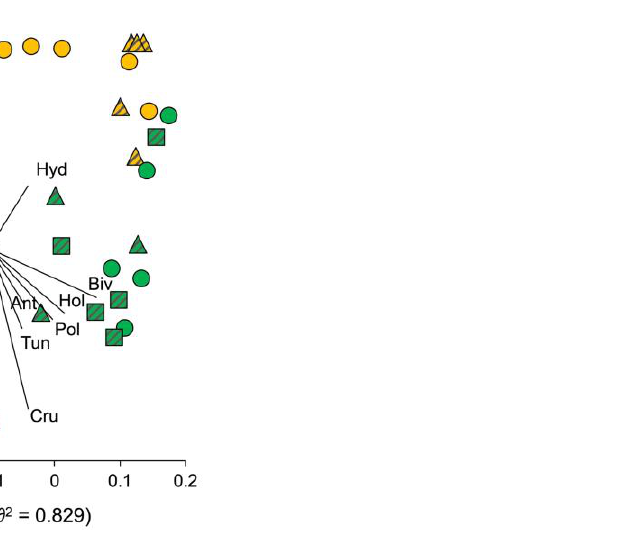
Figure 5. Canonical analysis of principal coordinates (CAP) for the factor Ti × Si based on the distance matrix among sampling units for total biomass of invertebrates at CIC. Squares (dashed) = control site 1 (C1), triangles (dashed) = control site 2 (C2), circles = no-take zone (P). Orange symbols = Time 1 (T1), green symbols = Time 2 (T2). Table 3. Results of asymmetrical PERMANOVA testing for differences between P and Cs in biomass of invertebrate assemblages associated to E. amentacea in both the investigated MPAs (PFN and CIC). The analysis is based on Bray–Curtis dissimilarities (untransformed data) and each test was per- formed using 5000 random permutations. Significant tests are provided in bold. Denominators for tests (MS DEN ) were also indicated.